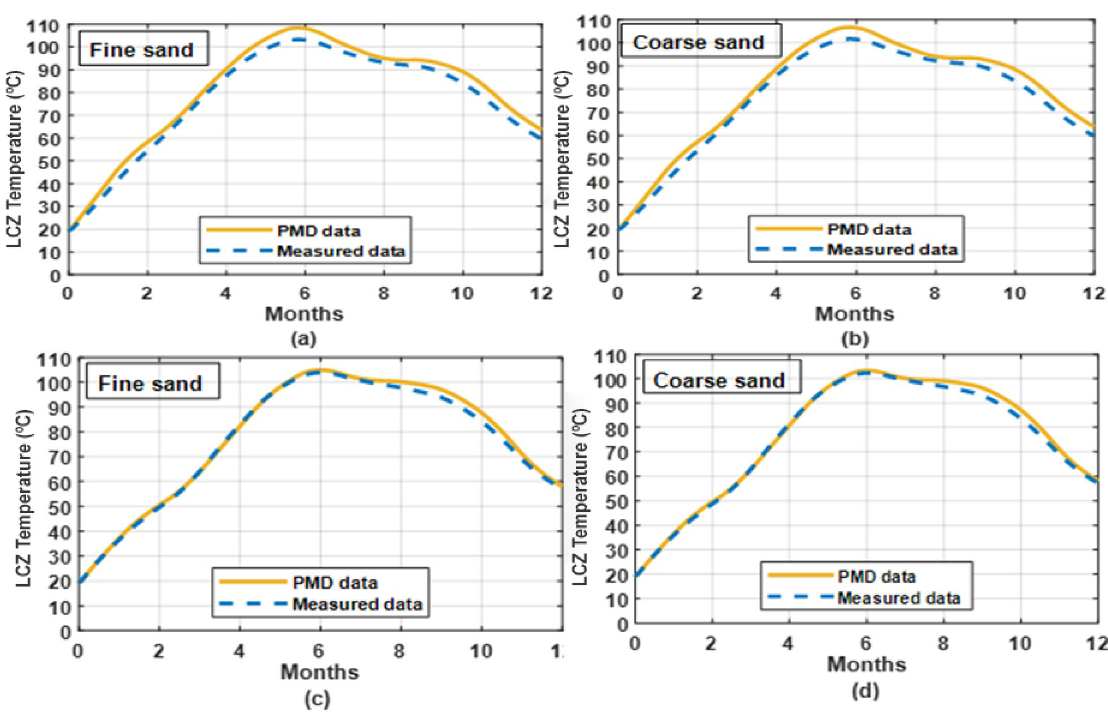
Fig 8. LCZ temperature with different sandy soil texture under the solar pond for whole year simulation under PMD and measured climatic conditions of Lahore (a), (b) and Islamabad (c), (d).